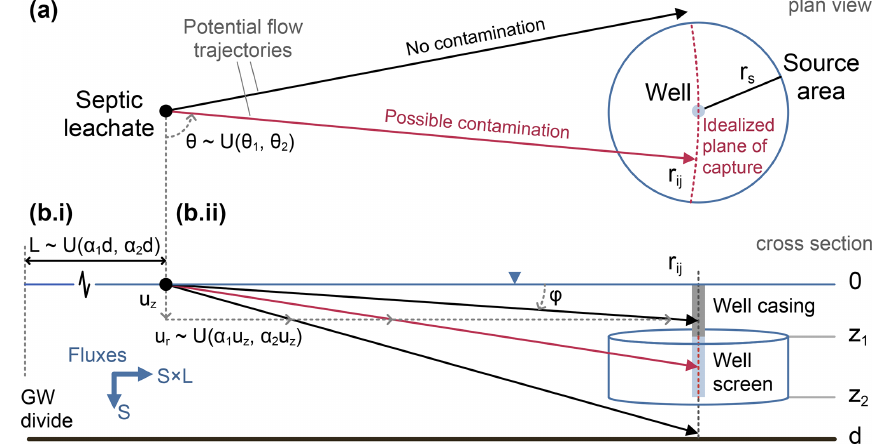
Figure 6. Groundwater model to determine the probability of contamination of well i from septic system j . (a) Plan view of the septic field, domestic well, and possible flow trajectories. The mean direction of flow is unknown and follows a uniform distribution with θ ∼ U( 0 , 2 π) . (b.i) Vertical and horizontal groundwater fluxes are determined by seepage, S , and the distance to the groundwater divide, approximated by L ∼ U( 0 ,L max ) . (b.ii) The well is cased to a depth z 1 and screened from z 1 to z 2 , with the possibility that contaminants can pass over or under the well. Velocities are determined from the fluxes such that u z = f (S) and u r = f (S × L) . It follows that u z is fixed, while u r contains the uncertainty represented by a uniform distribution. The well is contaminated if the flow path intersects the idealized plane of capture (red dashed line), thereby representing the source area of the well in both the horizontal and vertical planes. See the text for